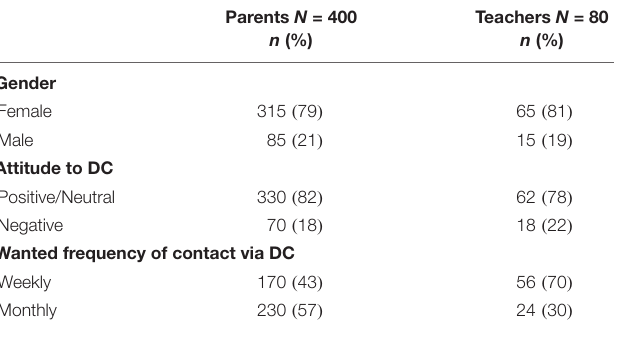
TABLE 1 | Participants, attitudes to DC, and wanted frequency of contacts via DC.